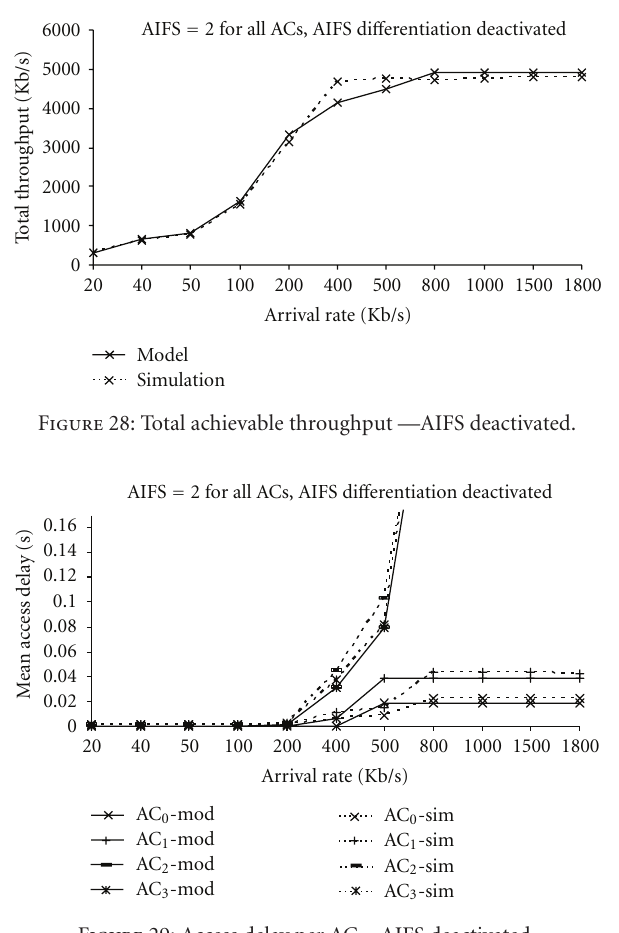
Figure 29: Access delay per AC—AIFS deactivated.